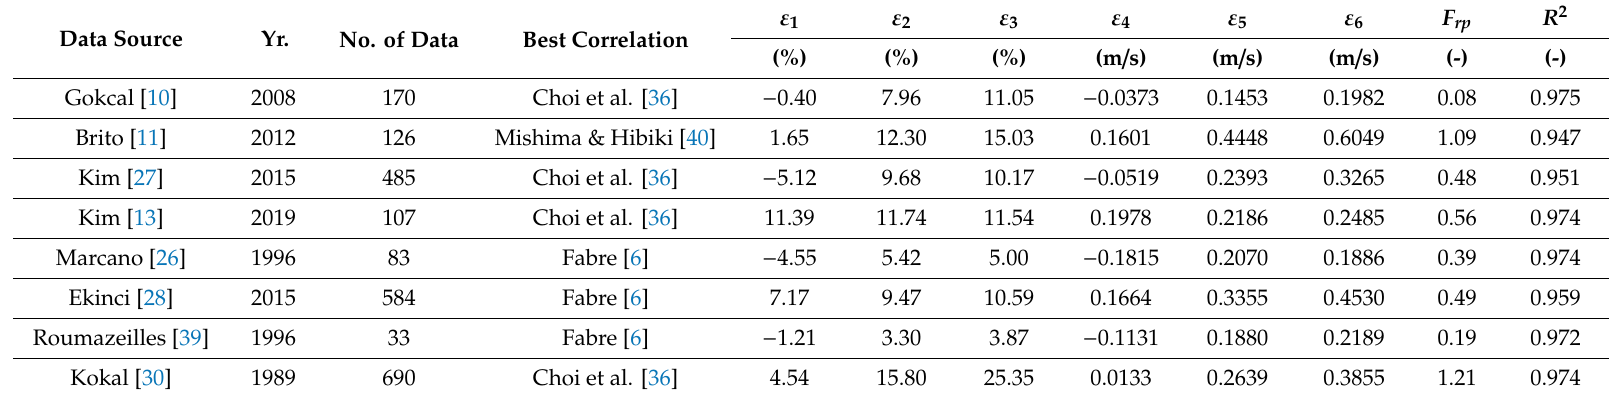
Table 5. Summary of the best performing correlations of translational velocity, v T .